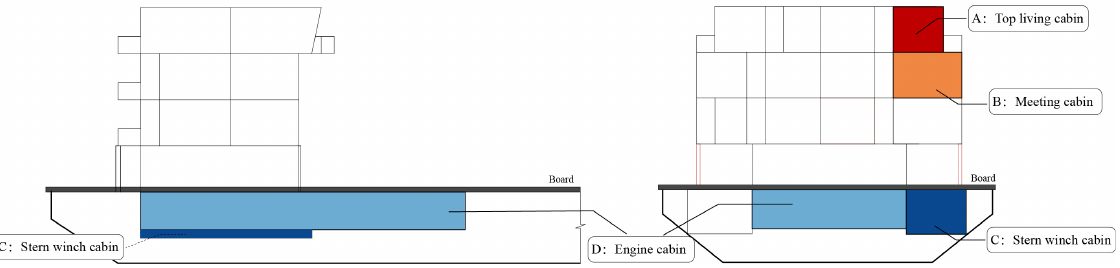
Figure 2. Changyan no. 10 ship.